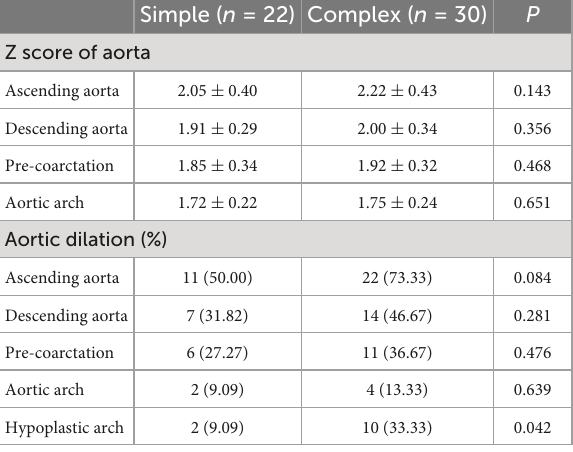
between the two groups. Simple ( n = 22) Complex ( n = 30)